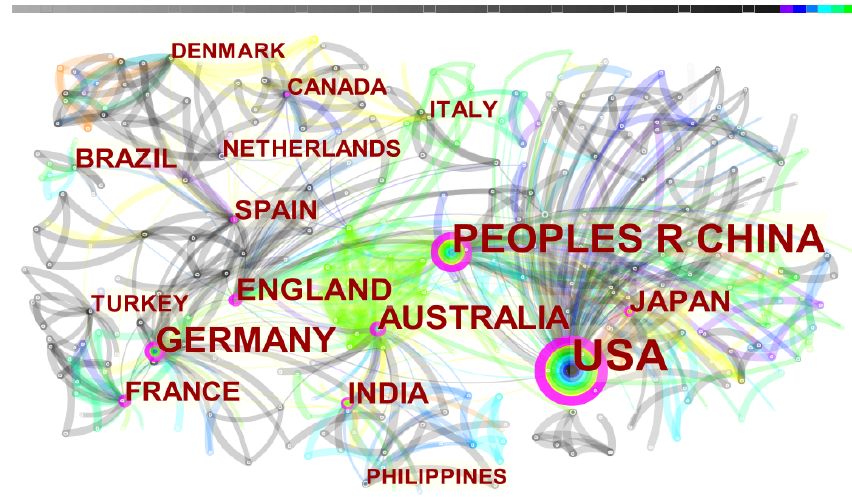
Figure 2. Analysis Diagram of WOS Cooperation Network.